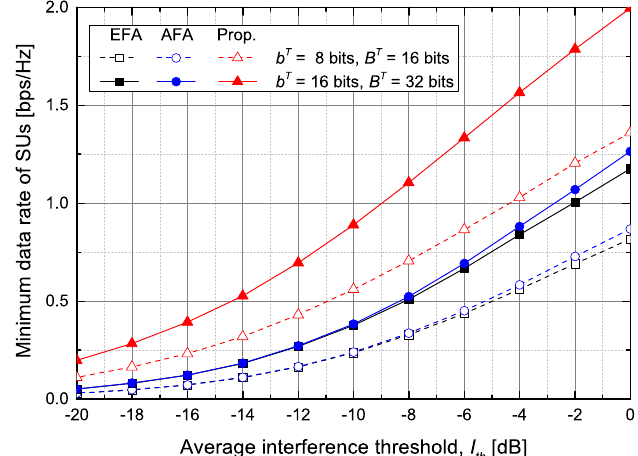
Figure 5. The minimum data rate of SUs versus the average inter-network interference threshold.